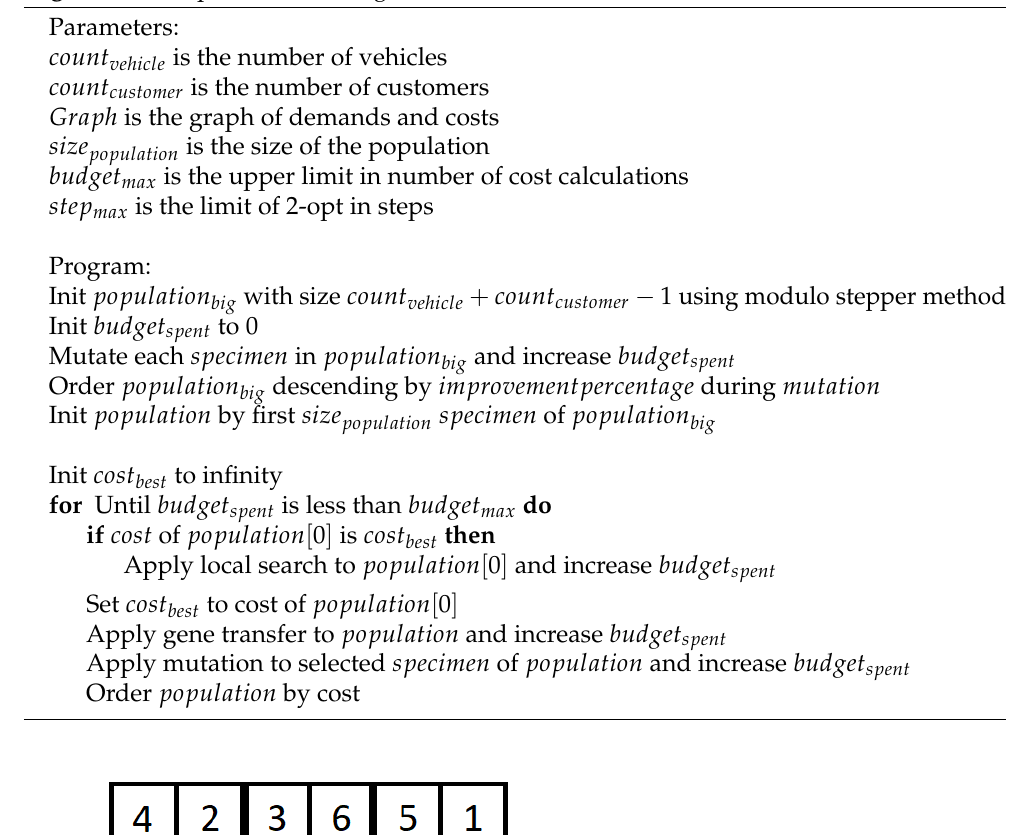
Algorithm 1 Improved BMA Algorithm